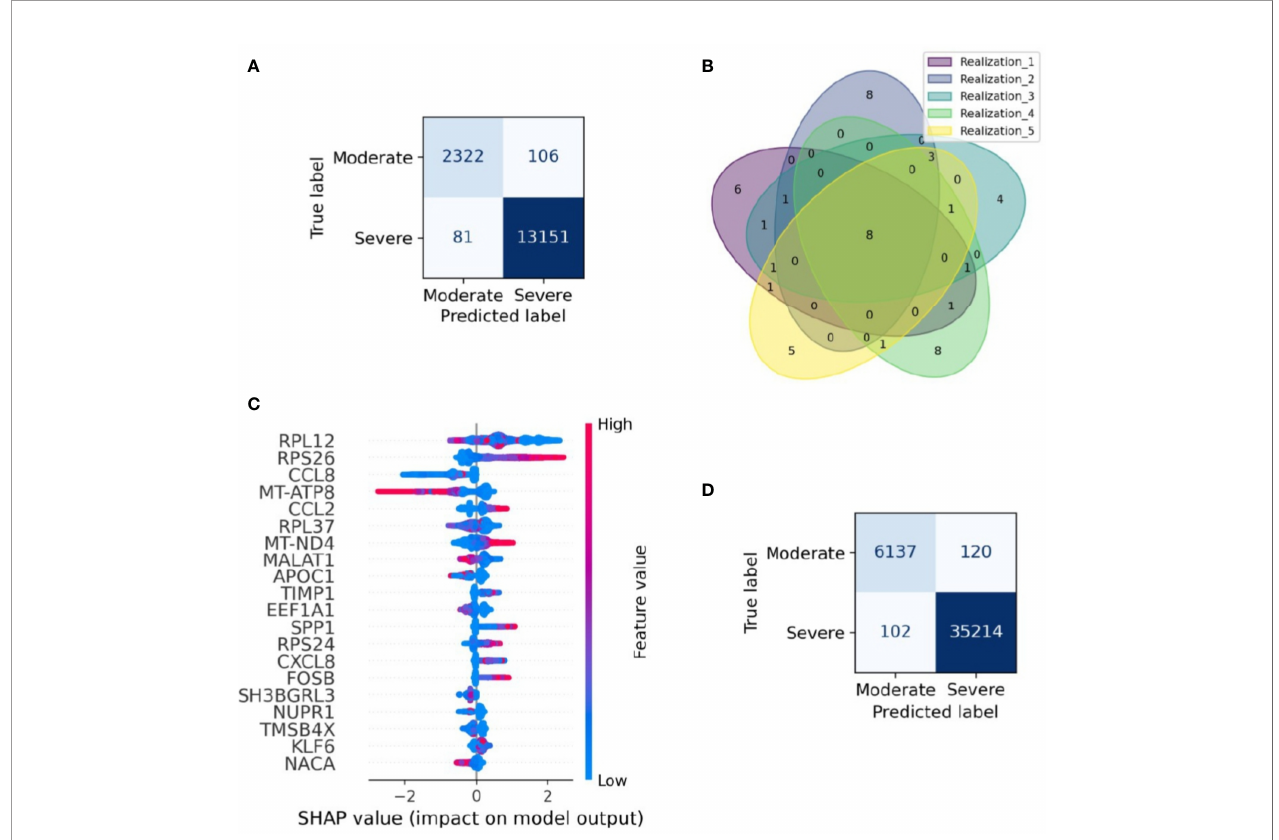
FIGURE 2 | Gene signature able to classify single-cell data from moderate and severe patients. (A) Confusion matrix of a realization. Each section shows the number of cells classi fi ed in each category. Dark blue sections indicate the number of cells correctly categorized. (B) Venn diagram of the relevant genes found on the fi ve realizations in the resampling process, numbers stand for genes shared across realizations. Eight genes were found in cross-validation analysis. (C) SHAP plot of one realization. In the fi gure, we depicted the fi rst twenty genes with higher contribution to the classi fi cation of moderate and severe patients. We have ordered the genes from high to low relevance from top to bottom. Blue and red colors represent low and higher gene expression, respectively. Larger positive values in the SHAP axis set the gene relevance to classify severe patients, whereas negative values set the gene relevance for moderate patients. (D) Validation confusion matrix. Each section shows the number of cells classi fi ed in each category. Dark blue sections indicate the number of cells correctly